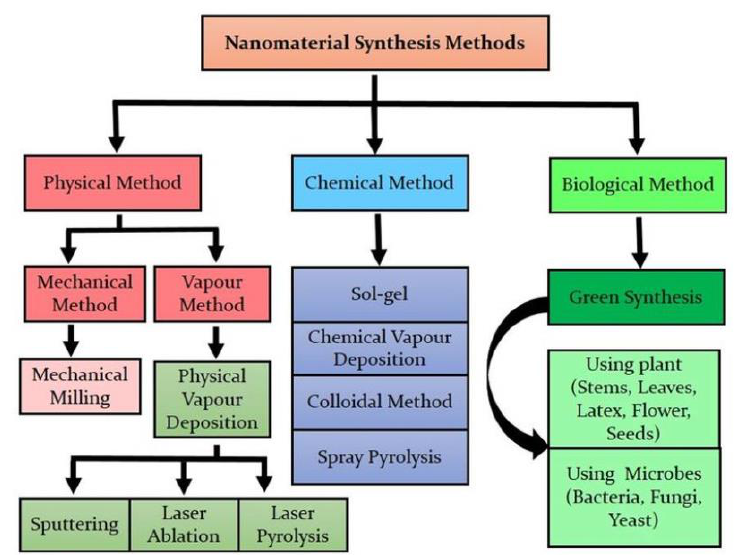
Figure 1. Methods of synthesizing nanomaterials. Reprinted with permission from [29]. Springer Nature (2020).